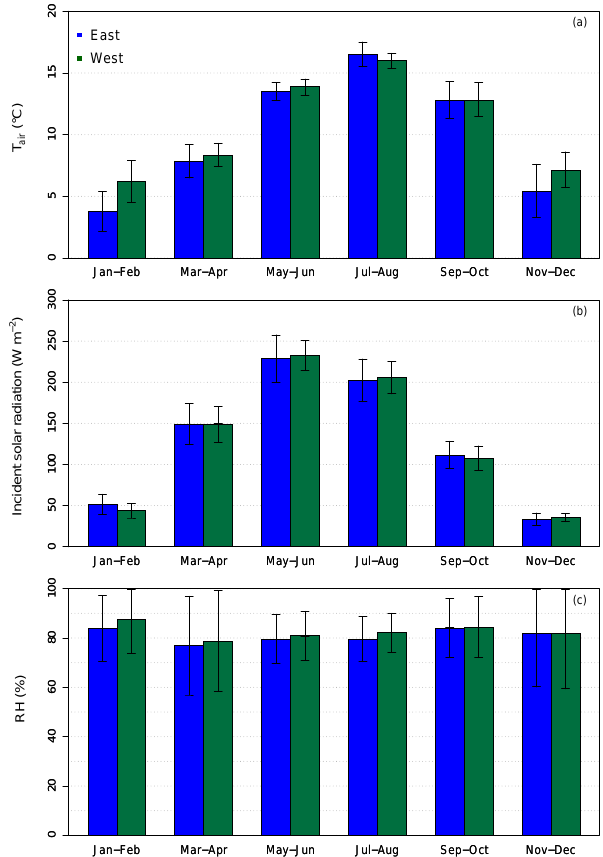
Figure 2. Average bimonthly values (2004–2012) for the key cli- matic variables of (a) air temperature, (b) incident solar radiation, S g , and (c) relative humidity for the east (blue) and west (green) sectors (error bars represent ± 1 standard deviation; n = 7) at the Straits Inclosure, Alice Holt